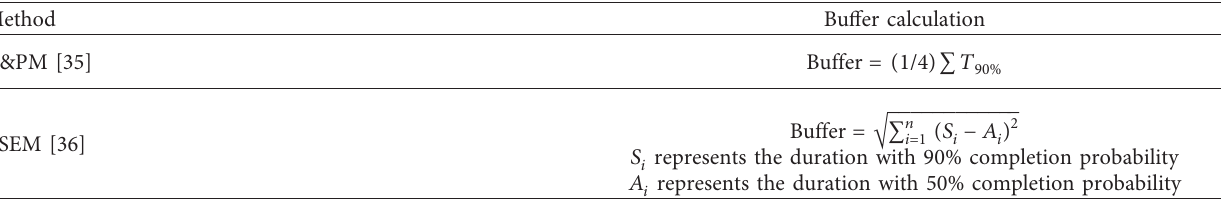
Table 1: Buffer calculation